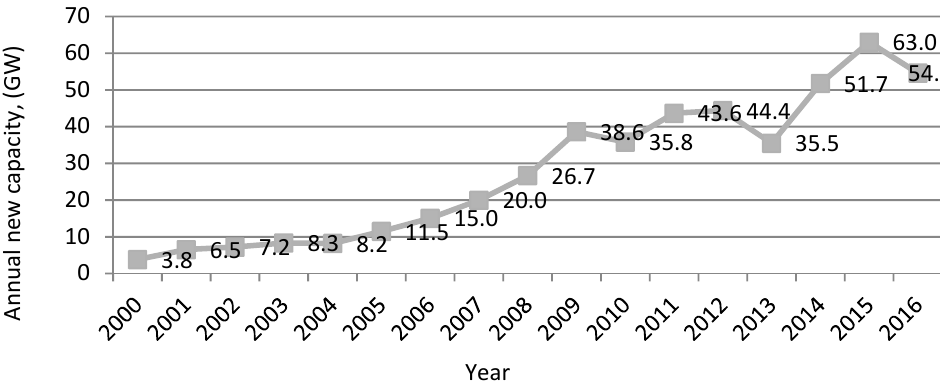
Figure 2. Annual global added wind power capacity [7].